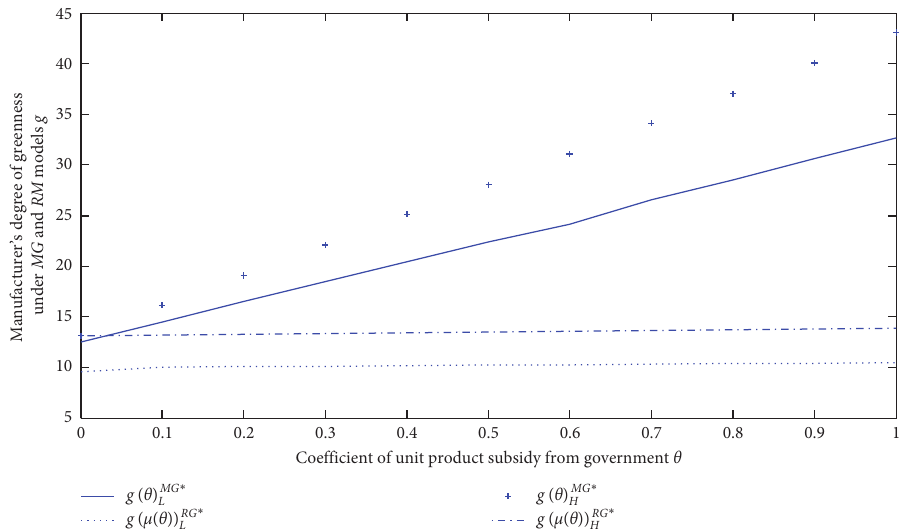
Figure 3: The impact of different government subsidy coefficients on the manufacturer’s greenness level under two